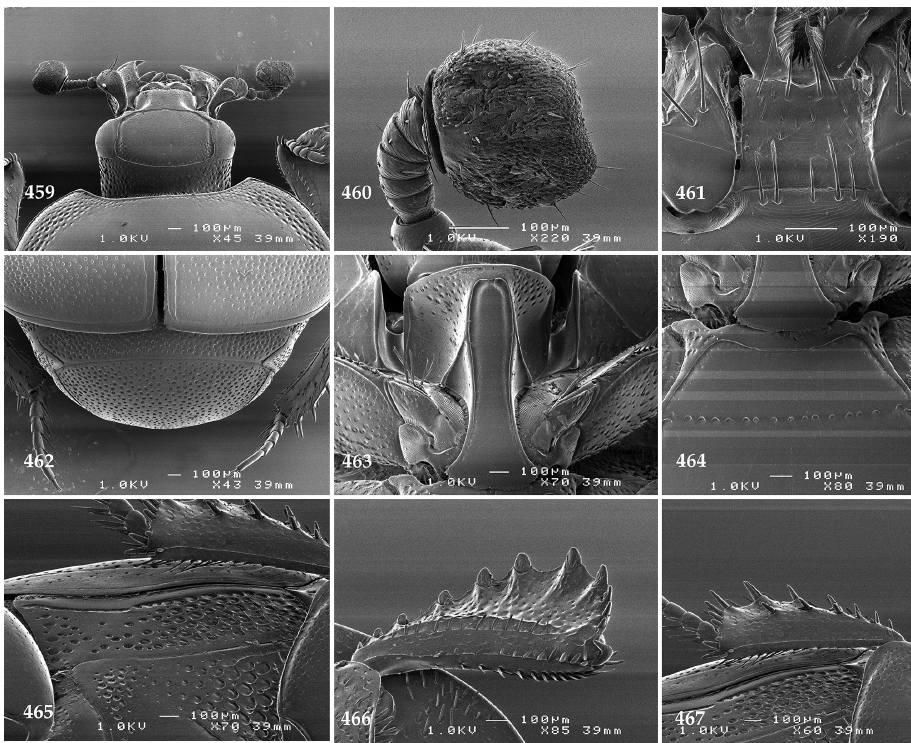
Figures 459–467. 459 Saprinus ( Saprinus ) laetus Erichson, 1834 head, dorsal view 460 antennal club, ventral view 461 mentum, ventral view 462 propygidium + pygidium 463 prosternum 464 mesoventrite 465 lateral disc of metaventrite + metepisternum 466 protibia, dorsal view 467 mesotibia, ventral